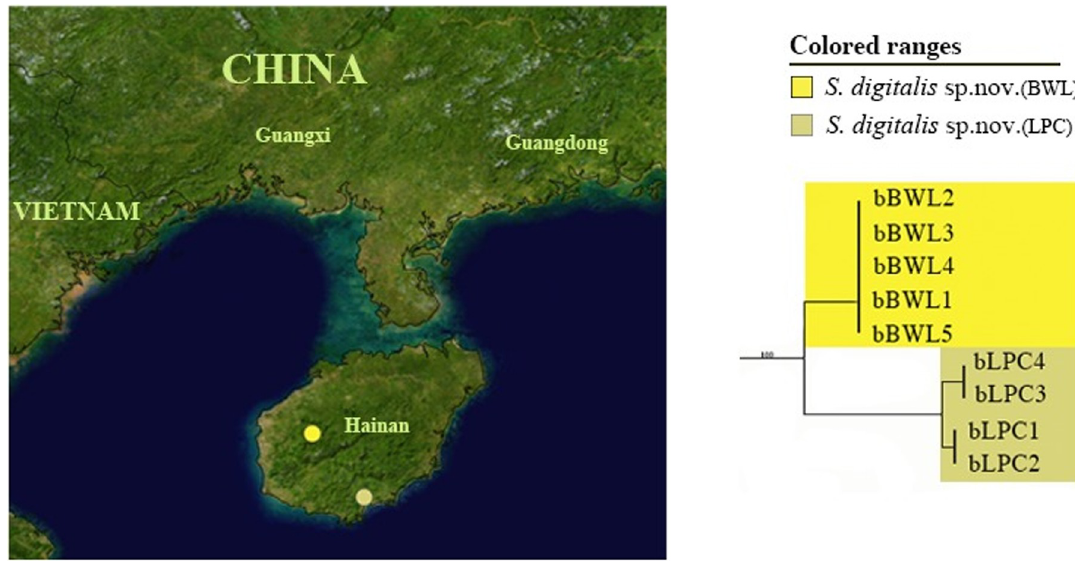
Fig 2. Pruned ML tree showing cryptic diversity of S . digitalis sp. nov. with MOTUs nomenclature and geographical locations. The map originates from “Blue Marble: Land Surface, Shallow Water, and Shaded Topography” (Visible Earth, NASA); all modifications were performed using Adobe Photoshop